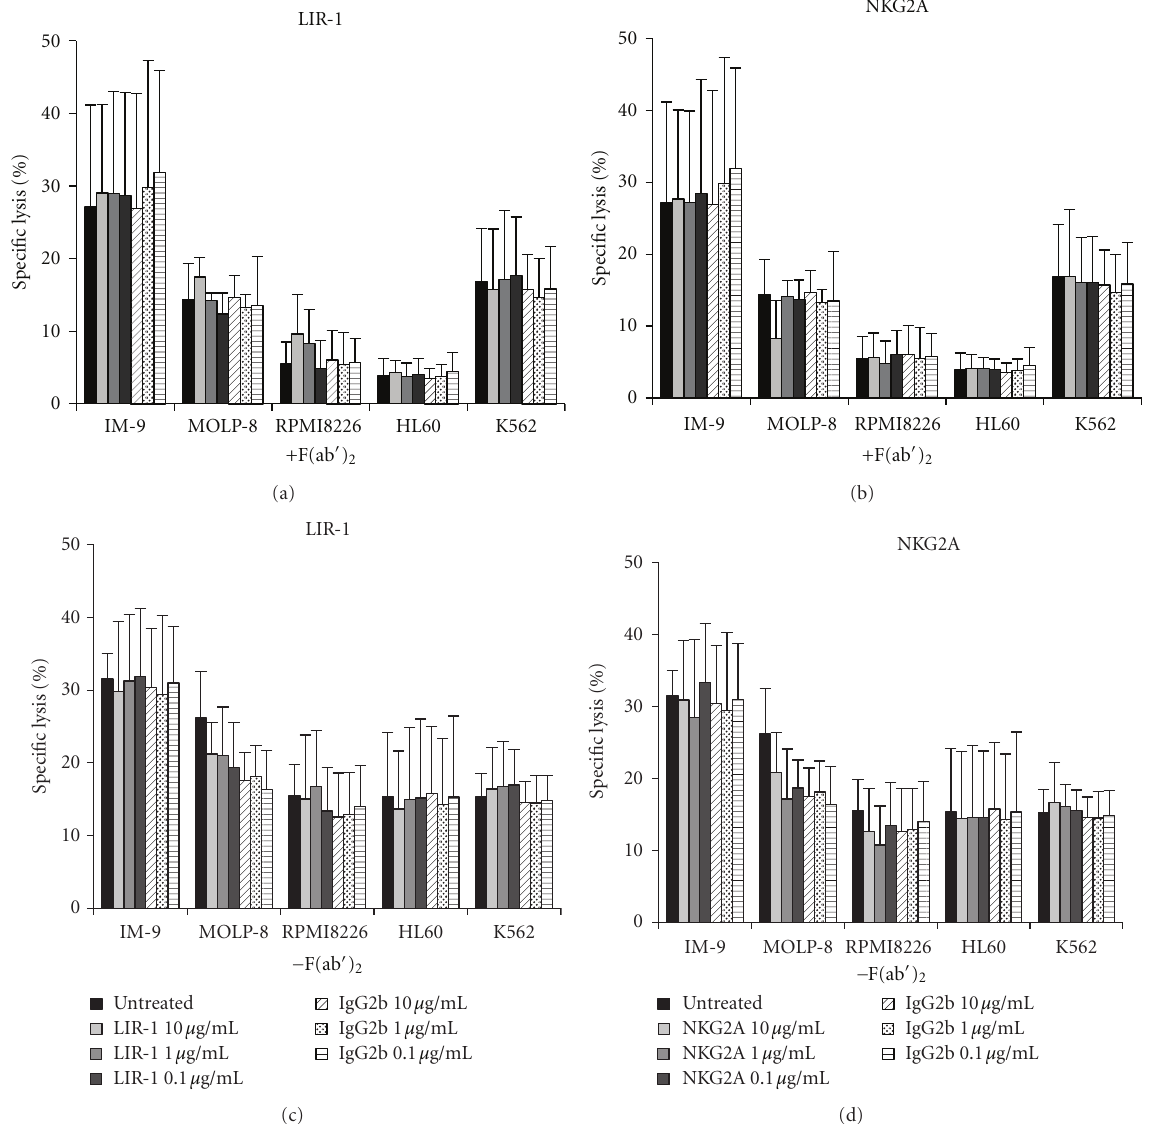
Figure 5: Blocking of CD85j and CD159a on NK-92 does not increase specific lysis. Blocking assays were performed as 4-hour CRA. NK-92 were preincubated with human serum and treated with the respective mAb (0.1, 1 and 10 μ g/mL). E:T ratio of 1.25 :1 was used throughout all experiments with a total of 5 × 10 3 target cells/200 μ l. Results are shown as means of triplicates of at least three independent experiments. (a/b): F(ab (cid:3) ) 2 was added after the last washing step prior to coincubation with target cells and maintained within the medium throughout the whole experimental period. (C/D): Samples without F(ab (cid:3) ) 2 . In samples classified as “untreated”, neither F(ab (cid:3) ) 2 nor Abs were used. SR was always < 20% for all cell lines except from MOLP-8, which showed a constantly high SR up to 36%. Statistical analysis was performed by ANOVA and did not show any significant e ff ect of Ab